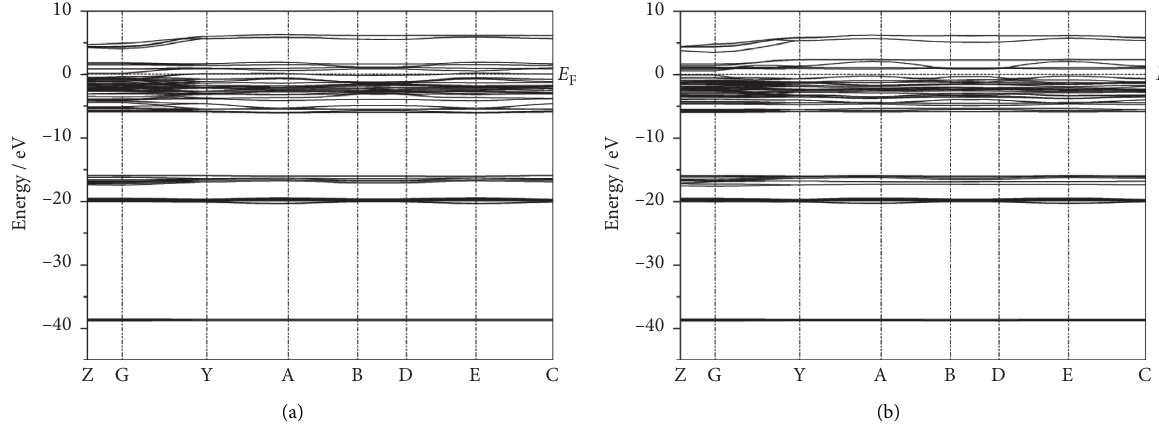
Figure 4: Electron band structures of sandwiched Ca 2 Co 2 O 5 crystalline oxide for (a) spin-up and (b) spin-down.